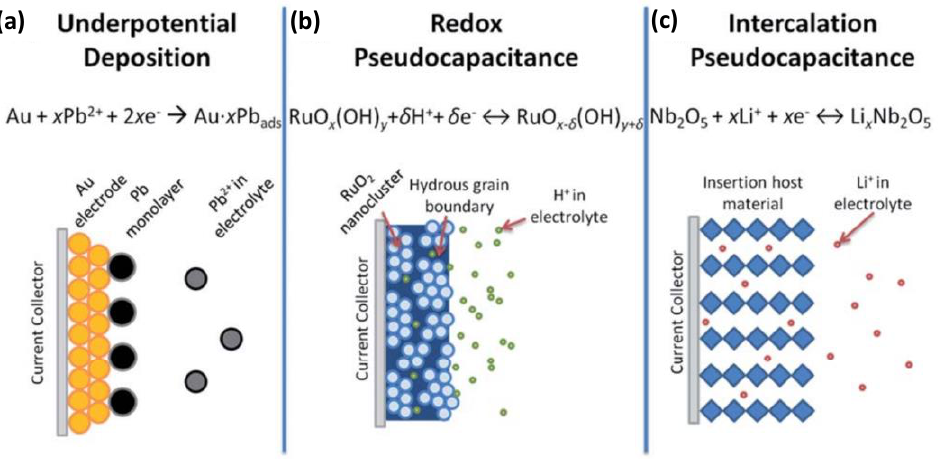
Figure 3. Schematics of the charge storage mechanisms for ( a ) EDLCs and ( b – d ) different types of pseudocapacitive electrodes: ( b ) underpotential deposition pseudocapacitor, (c) redox pseudo- capacitor, and ( d ) ion intercalation pseudocapacitor. Reproduced with permission [11] . Copyright © 2022, American Chemical Society.